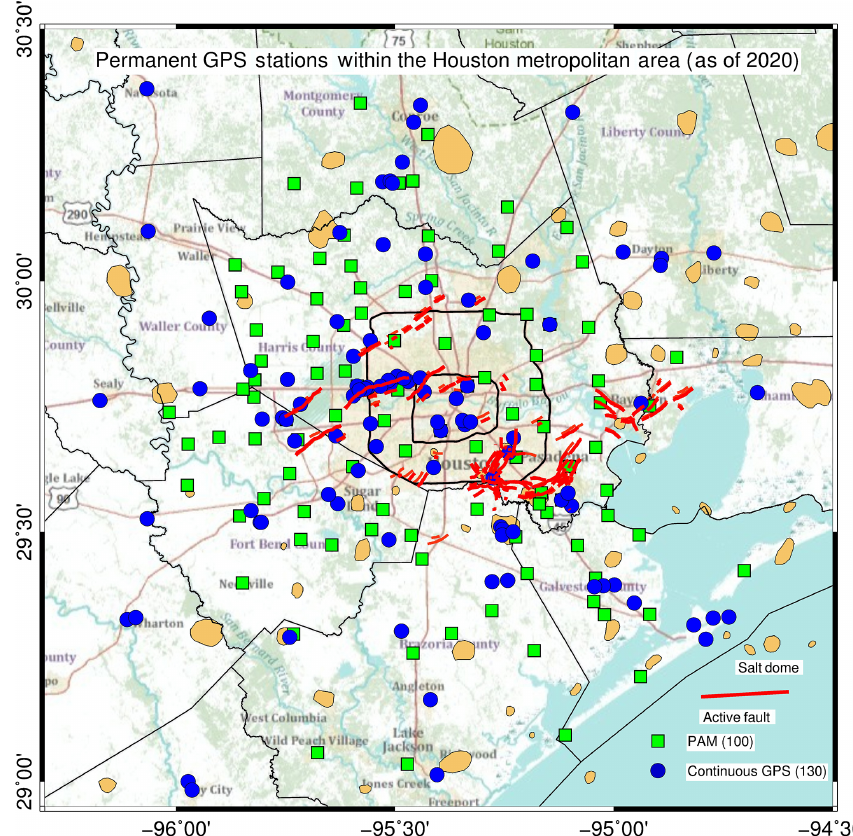
Figure 1. HoustonNet permanent GPS stations in the Greater Houston region as of early 2020. The red lines represent active faults mapped by USGS (Shah and Lanning-Rush, 2005); the orange filled polygons represent salt domes mapped by USGS (Huffman et al.,